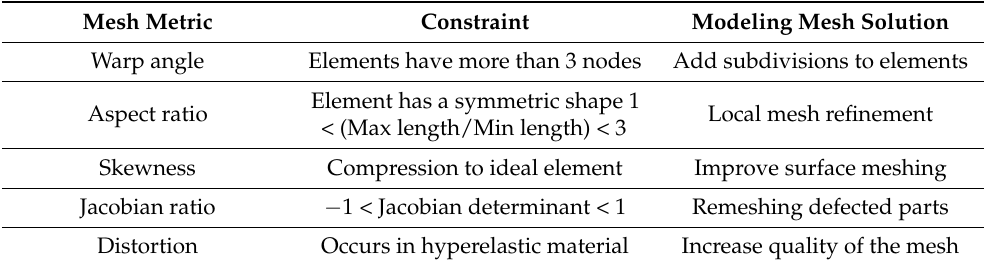
Table 4. Mesh metrics specs and FEA meshing solutions to their numeric